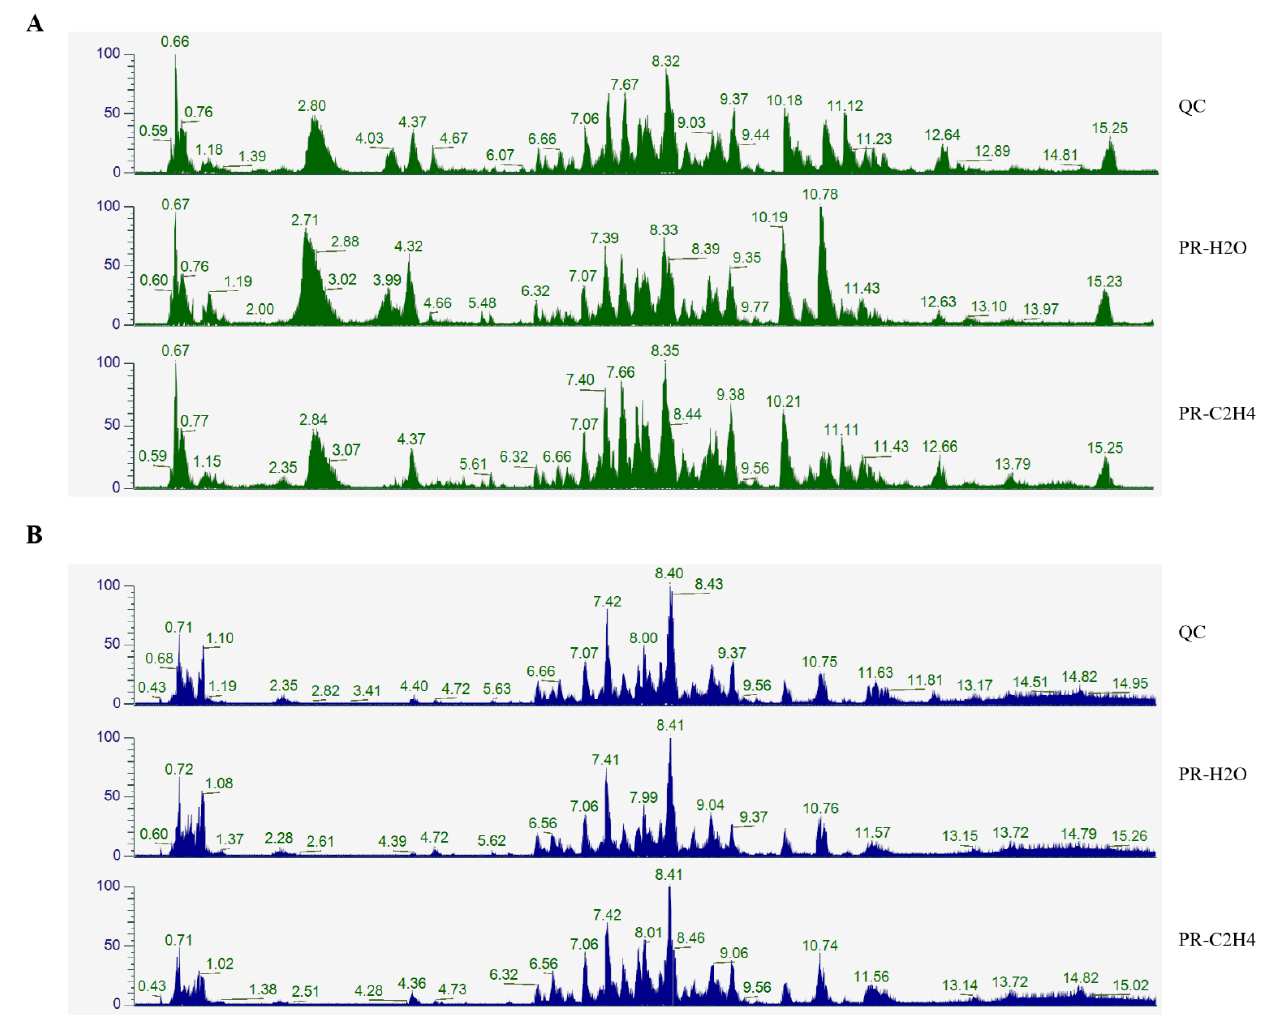
Figure 2. The base peak chromatogram of metabolites. ( A ) Positive ion; ( B ) negative ion. QC, quality control sample; the QC sample was generated from a mixture of equivalent quantities of the 12 samples in this study; PR-C 2 H 4 and PR-H 2 O represent the primordia of G. lucidum treated with ethylene and water, respectively.